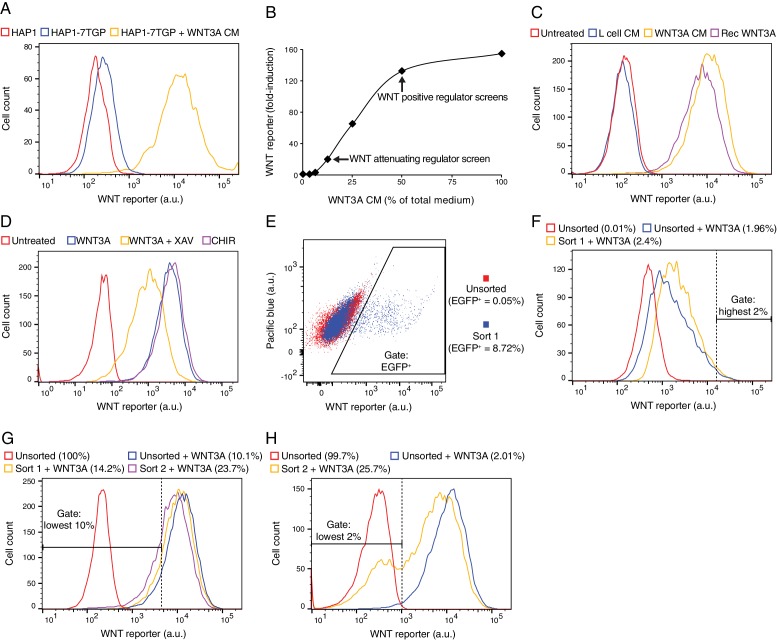
Characterization of HAP1-7TGP, a haploid human cell line harboring a WNT-responsive fluorescent reporter (A–D), and depiction of FACS gates and phenotypic enrichment during various reporter-based forward genetic screens (E–H).(A) Histogram depicting WNT reporter activity (EGFP fluorescence of ~4500 cells in arbitrary units (a.u.), plotted on a logarithmic x-axis) for the parental haploid human cell line HAP1 and the WNT reporter cell line HAP1-7TGP. Where indicated, cells were treated with 50% WNT3A conditioned medium (CM). Basal EGFP fluorescence in HAP1-7TGP cells was minimal and increased by approximately two orders of magnitude in response to WNT3A. (B) Dose response curve depicting fold-induction in WNT reporter (average EGFP fluorescence from ~3500 cells) following treatment with WNT3A, as a function of WNT3A CM concentration (expressed as percentage of total medium). The WNT3A CM concentrations used in the screens for attenuating and positive regulators of WNT signaling (Figure 1D–1F) are indicated. EGFP fluorescence in HAP1-7TGP cells increased by up to 155-fold in response to saturating WNT3A. (C) Histogram depicting WNT reporter activity for ~10,000 HAP1-7TGP cells. Where indicated, cells were treated with 50% control CM from L-cells, 50% WNT3A CM or 150 ng/ml recombinant WNT3A. HAP1-7TGP cells responded to WNT3A CM and recombinant WNT3A, but not control CM. (D) Histogram depicting WNT reporter activity for ~5000 HAP1-7TGP cells. Where indicated, cells were treated with 50% WNT3A CM alone or together with 10 μM of the tankyrase inhibitor XAV-939, which elevates the levels of AXIN, or with 10 μM of the GSK3 antagonist CHIR-99021. WNT3A-induced reporter expression in HAP1-7TGP cells has the pharmacological hallmarks of being mediated by canonical WNT signaling. (E) Dot plot depicting WNT reporter activity (EGFP fluorescence vs. pacific blue auto-fluorescence from ~17,500 cells, plotted on biexponential axes) for HAP1-7TGP cells mutagenized with GT retrovirus and enriched during the WNT negative regulator screen (Figure 1C). Unsorted cells and cells amplified following sort 1 using the indicated EGFP+ gate are depicted, and the percentage of cells within this gate for each population is indicated in parenthesis. Cells were analyzed for GT insertions following a second round of FACS sorting (not shown) using an equivalent gate. (F) Histogram depicting WNT reporter activity for ~7000 mutagenized HAP1-7TGP cells enriched during the WNT attenuating regulator screen (Figure 1D). Where indicated, cells were treated with 12.5% WNT3A CM. Unsorted cells and cells amplified following sort 1 using the indicated highest 2% EGFP fluorescence gate are depicted. The percentage of cells within this gate for each population is indicated in parenthesis. Cells were analyzed for GT insertions following a second round of FACS sorting (not shown) using an equivalent gate. (G) Histogram depicting WNT reporter activity for ~12,500 mutagenized HAP1-7TGP cells enriched during the WNT positive regulator screen done at low stringency (Figure 1E). Cells were treated with 50% WNT3A CM where indicated. Unsorted cells and cells amplified following sort 1 or sort 2 using the indicated lowest 10% EGFP fluorescence gate are depicted, and the percentage of cells within this gate for each population is indicated in parenthesis. (H) Histogram depicting WNT reporter activity for ~12,500 mutagenized HAP1-7TGP cells enriched during the WNT positive regulator screen done at high stringency (Figure 1F). Cells were treated with 50% WNT3A CM where indicated. Unsorted cells and cells amplified following sort 2 using the indicated lowest 2% EGFP fuorescence gate are depicted, and the percentage of cells within this gate for each population is indicated in parenthesis.